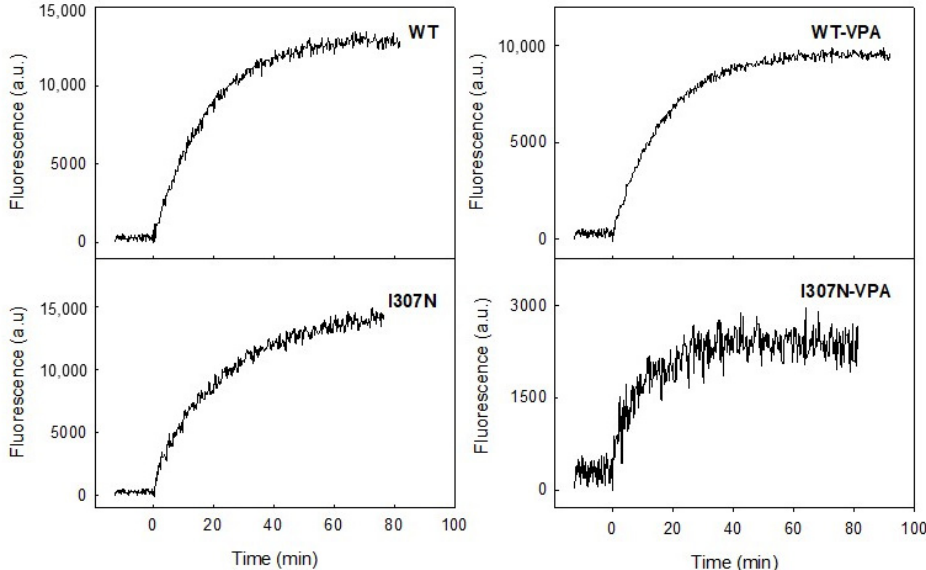
Figure 5. Fluorescence Retinal Release Curves: The figure shows representative curves for the purified Rho WT and mutant samples measured by means of fluorescence spectroscopy (the I307N mutant without and with VPA treatment is shown in comparison to WT Rho). The fluorescence curves represent the retinal release from the Rho binding pocket which closely parallels the Meta II decay process. The protein samples were incubated at 20 ◦ C until a steady baseline was obtained, they were subsequently photobleached and the Trp fluorescence increase was monitored over time. The fluorescence increase curve was fit to a single exponential function and the t 1/2 ob- tained.